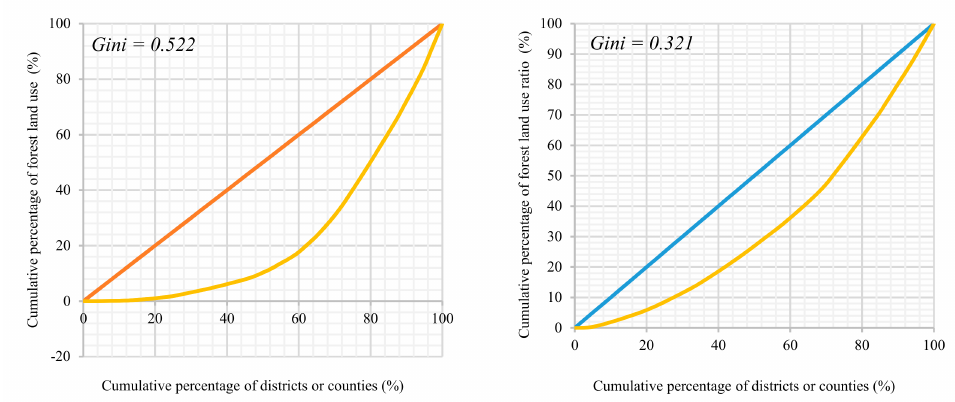
Figure 5. The Lorenz Curve of forest land and its ratio to total land area in 2015; Source: edited by authors.